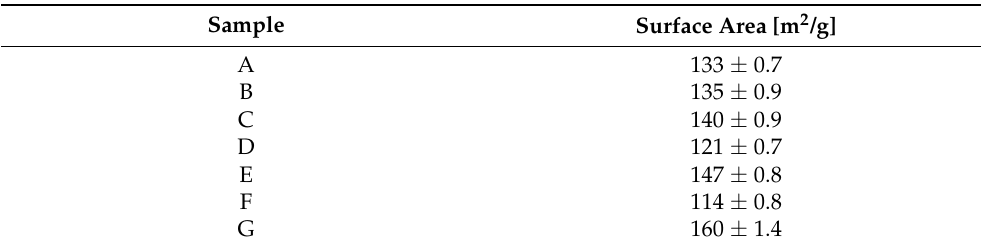
Table 1. Specific surface area values for the prepared samples. The sample designations are the same as in Section